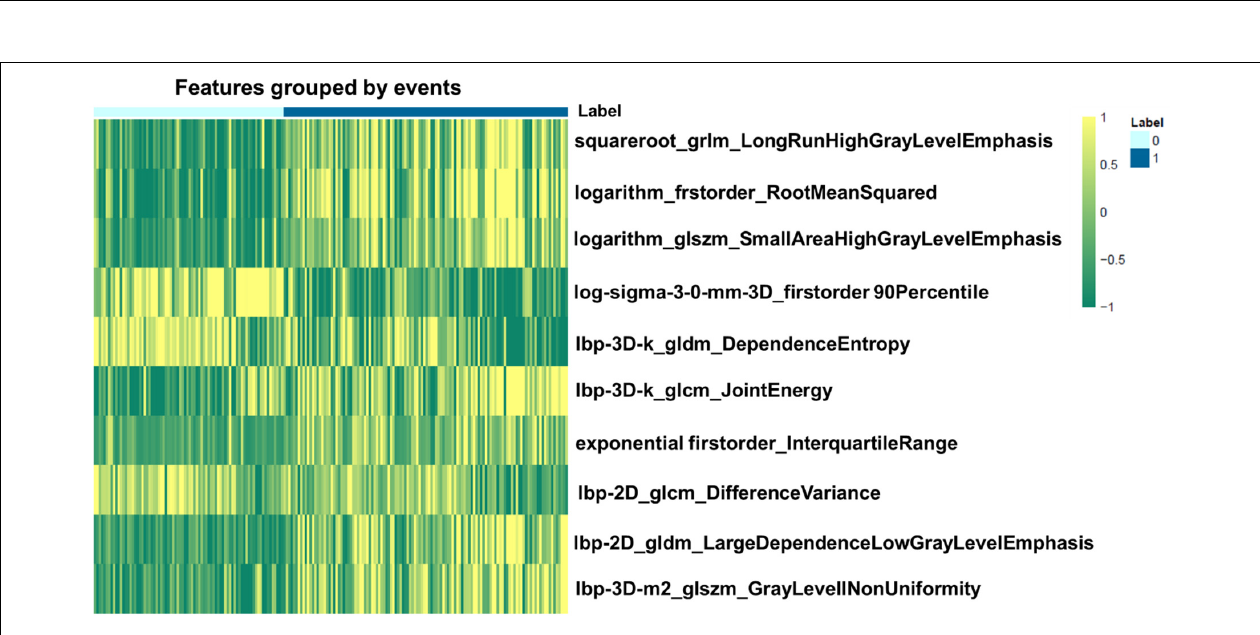
FIGURE 3 | Heatmap of the 10 most relevant radiomics features of global myocardium for differentiating cardiac amyloidosis (CA) from non-CA patients. 0 represents the patients without CA, while 1 represents positive CA patients.